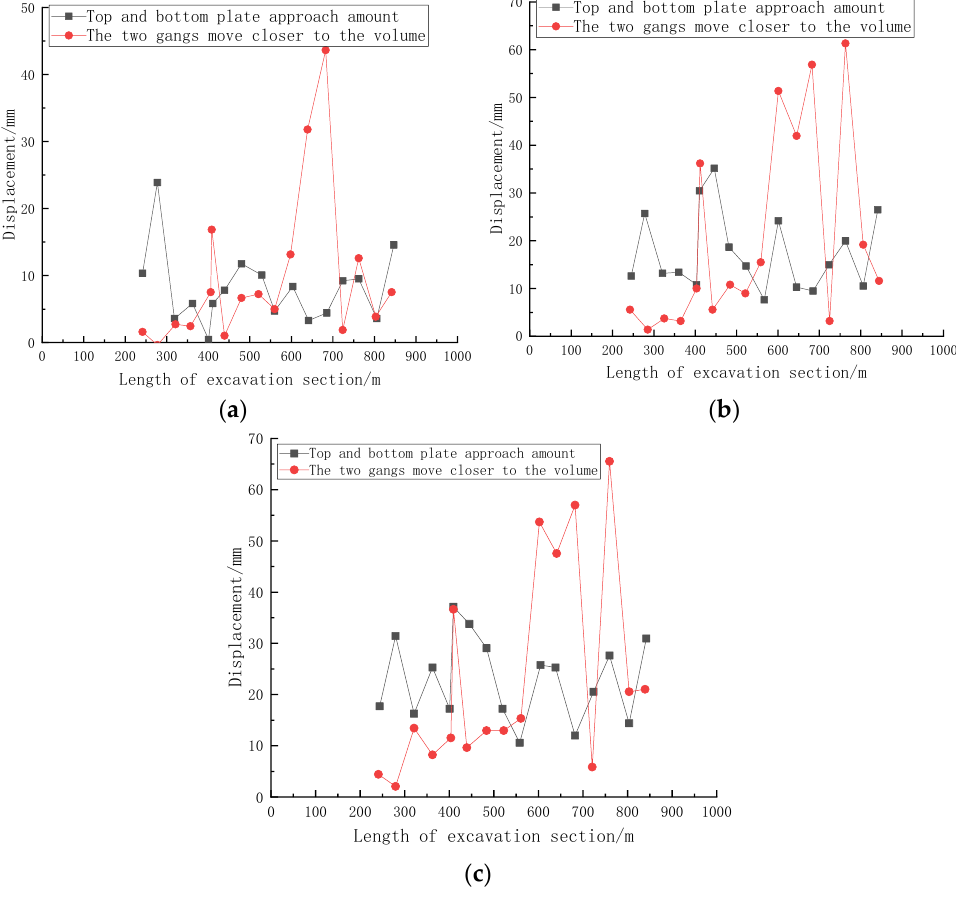
Figure 2. Figure for 30503: ventilation roadway. ( a ) Day 3 alleyway deformation. ( b ) Day 7 alleyway deformation. ( c ) Day 10 alleyway deformation.